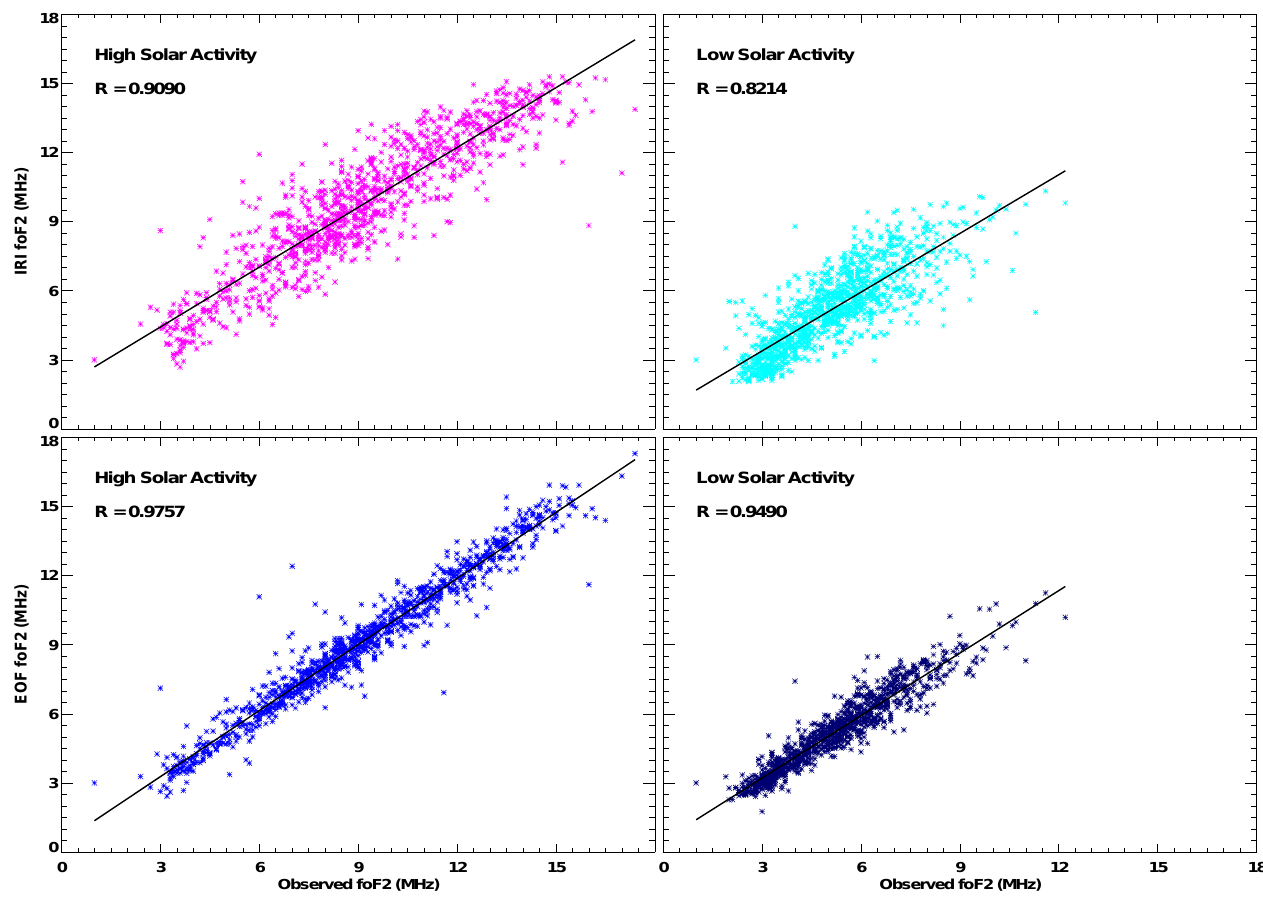
Fig. 8. Scatter plots of IRI and EOF model values versus observational data of fo F2.